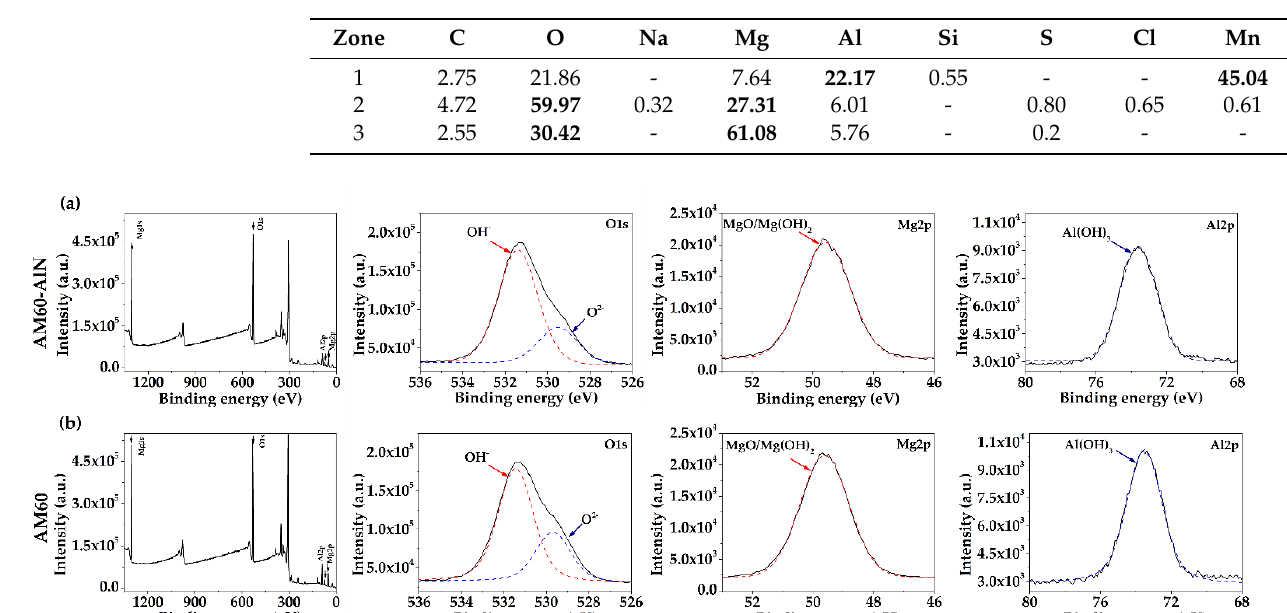
Figure 7. SEM images (x2000) of AM60-AlN nanocomposite and AM60 alloy surface morphology: ( a , b ) at 30 days of immersion in SME model solution; ( c , d ) after elimination of corrosion layers; ( e , f ) cross-sectional SEM images. Table 3. EDS analysis (wt.%) of nanocomposite AM60-AlN and AM60 surfaces (in zones labeled in Figure 7), after immersion in SEM model solution up to 30 days.